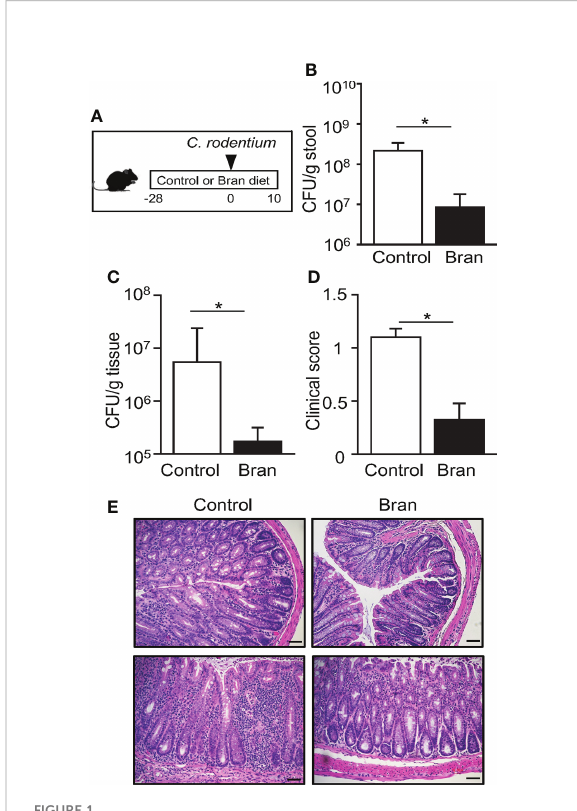
FIGURE 1 Consuming rice bran decreases susceptibility to C. rodentium infection. (A) Experimental approach. (B) Colony-forming units (CFUs) of C. rodentium in stool of infected control- or 20% rice bran diet-fed mice, normalized to sample weight, days 3 post- infection. (C) CFUs of C. rodentium in the colon tissues, day 10 post-infection. (D) Clinical scores representing severity of diarrhea, day 10 post-infection. (E) Histological staining of the colon tissues of infected mice, day 10 post-infection. Scale bars: 10 m m. Data are representative of 2-3 independent experiments. n = 4 per group. Results are mean ± SEM. * p <